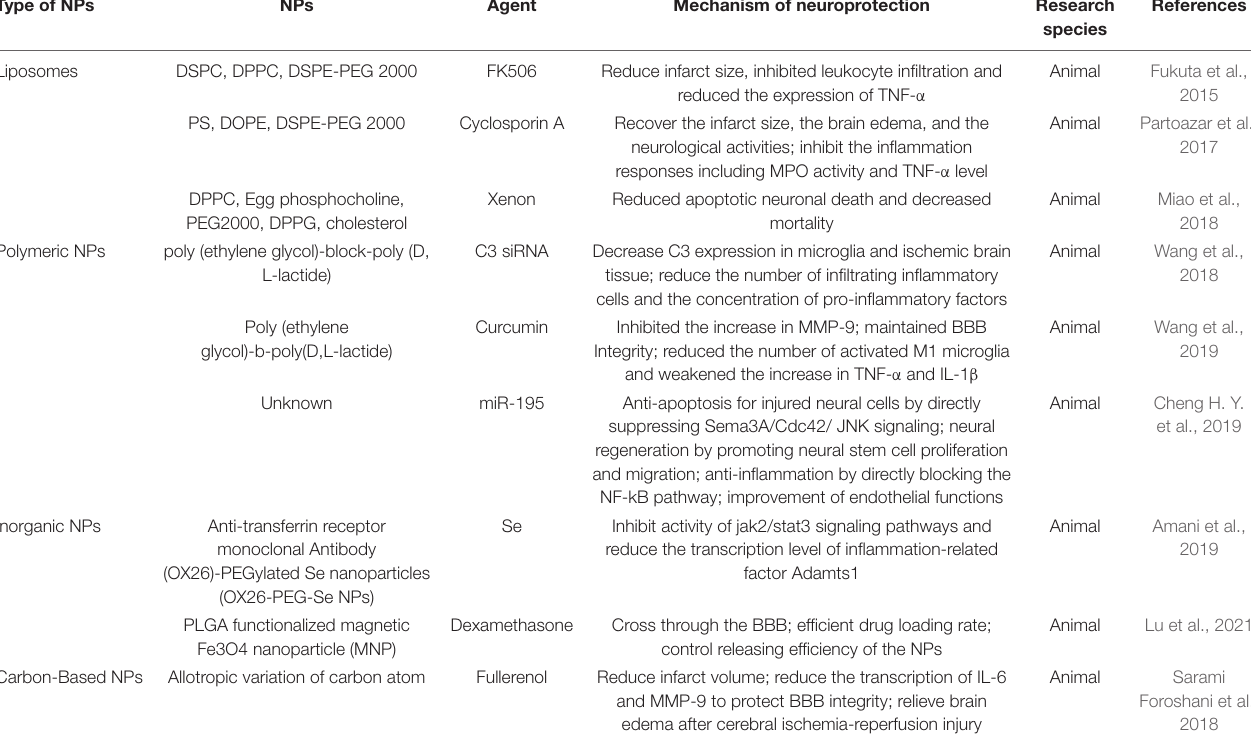
TABLE 1 | Summary of targeted delivery of anti-inflammatory agents with